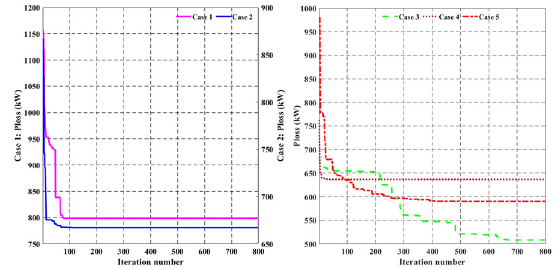
Fig. 16: Convergence Curve of Case 1 To Case 5 for IEEE 119-Bus